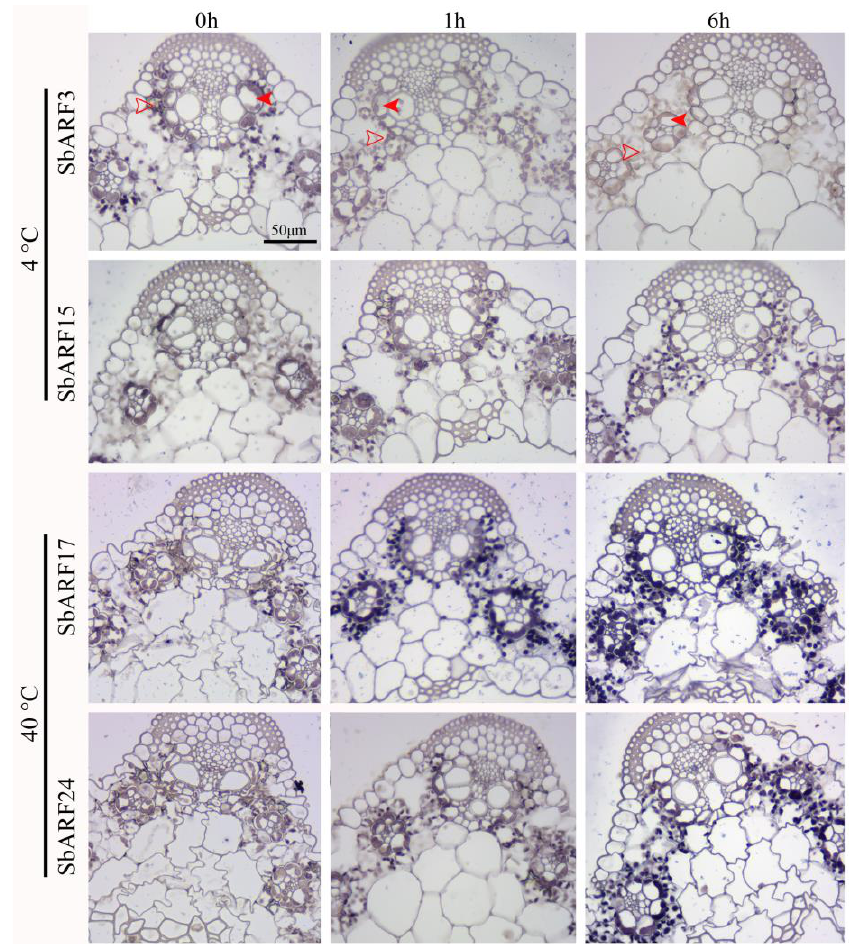
Figure 6. In situ hybridization analysis of SbARF genes in seedling leaves under temperature stress. Solid and feint red arrows indicate the regions of vascular bundle sheath cells and the surrounding parenchyma cells, respectively.